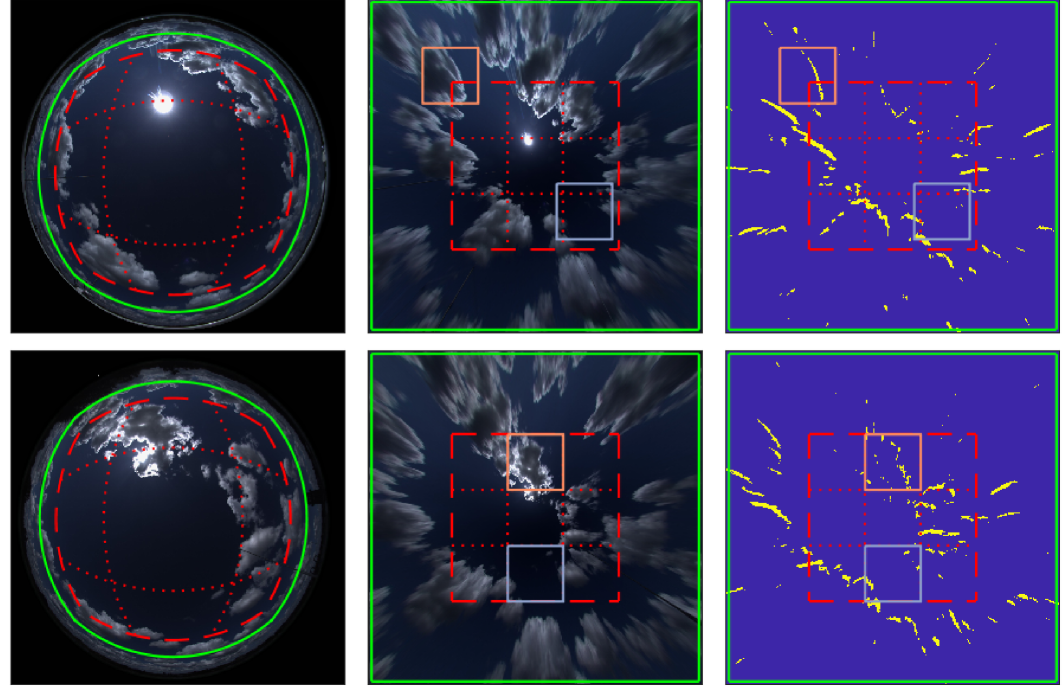
Figure 3. Sky areas evaluated in the measurement of the CBH exemplary for the ASI pair FLE-UOL, with ASI UOL in the top row and FLE in the bottom row. Shown are the maximum extent (solid green shape) and area used by the main camera in the default case (red shape, dashed line) in the distorted ASI image (left), in the undistorted orthoimage (center) and in the binary red channel difference image of two consecutive exposures (right). The binary red channel difference image (right) indicates the areas considered as being features in the cross- correlation for the comparison to the second camera with yellow shapes. A rejected match between the ASI images is marked in orange, and a valid match is marked in grayish